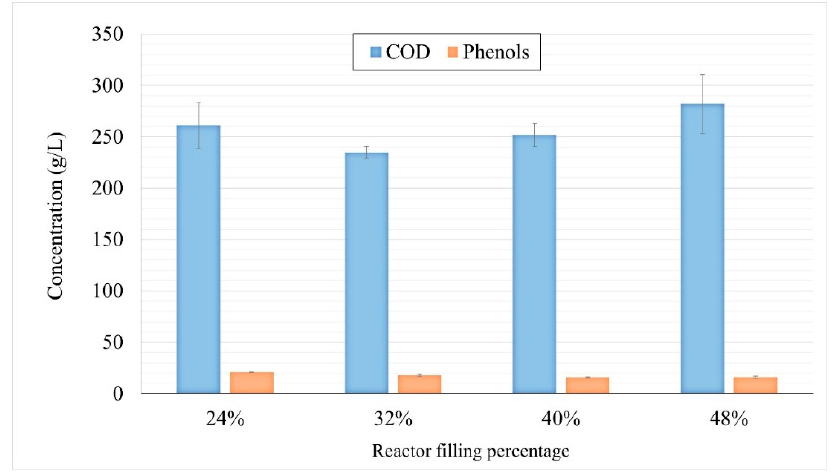
Figure 6. COD and TPC for different filling percentages of the HTC reactor.